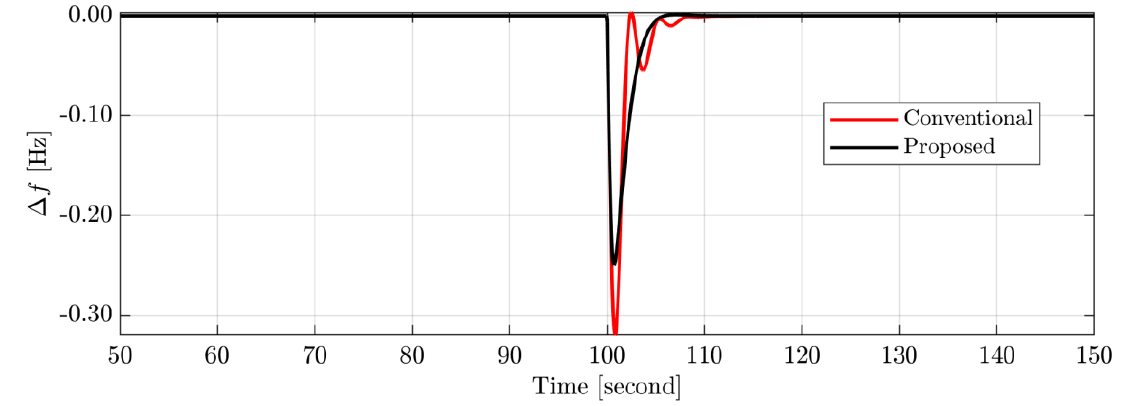
Figure 12. System frequency deviation of the studied µG for the case 2.